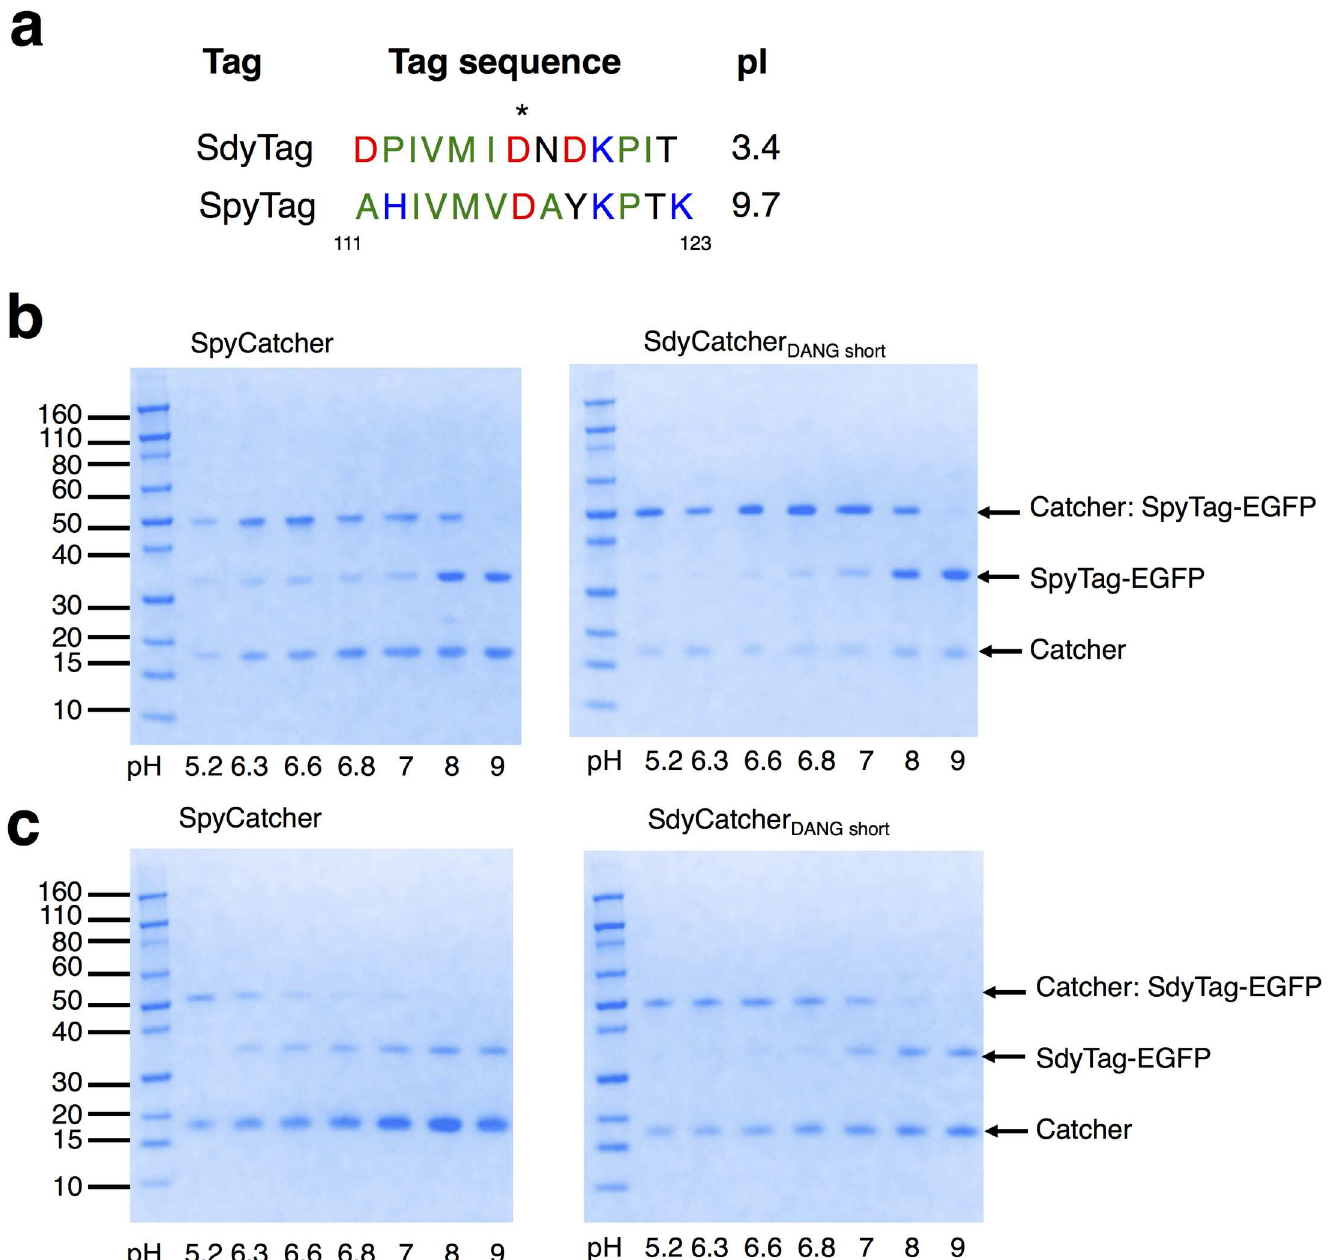
Fig 3. Tag variants. (a) Alignment of Tags. Hydrophobic, neutral, negatively-charged and positively-charged residues are colored as green, black, red and blue respectively. The residue numbering follows that of Fig 1B. The reactive Asp117 is indicatedwith a star. (b, c) pH dependence of SpyTag and SdyTag. (b) Incubation of SpyTag-EGFP with SpyCatcher (left) and SdyCatcher DANG short (right) at pH 5.2, 6.3, 6.6, 6.8, 7, 8 and 9 after 10 minute at 25˚C. (c) Incubationof SdyTag-EGFP with SpyCatcher (left) and SdyCatcher DANG short (right) at pH 5.2, 6.3, 6.6, 6.8, 7, 8 and 9 after 30 minute at 25˚C.